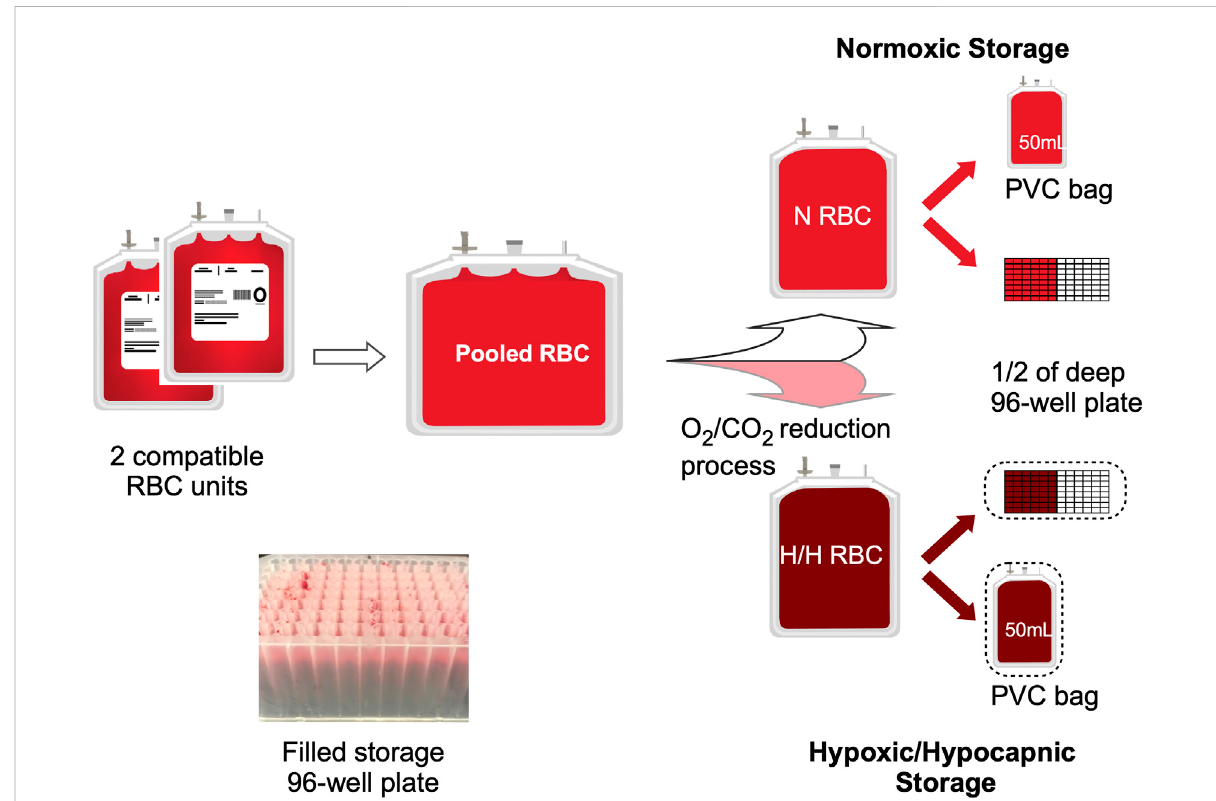
FIGURE 1 Experimental set-up. The diagram shows the processing and splitting procedure for one pool of 2 compatible RBC units. One half of the split pool remained N, and the second half was processed for O 2 /CO 2 reduction (H). Each N or H pool was then plated into a half of the 96-well 2 ml storage plate as well as a PVC bag. (Insert) Image of set-up sample